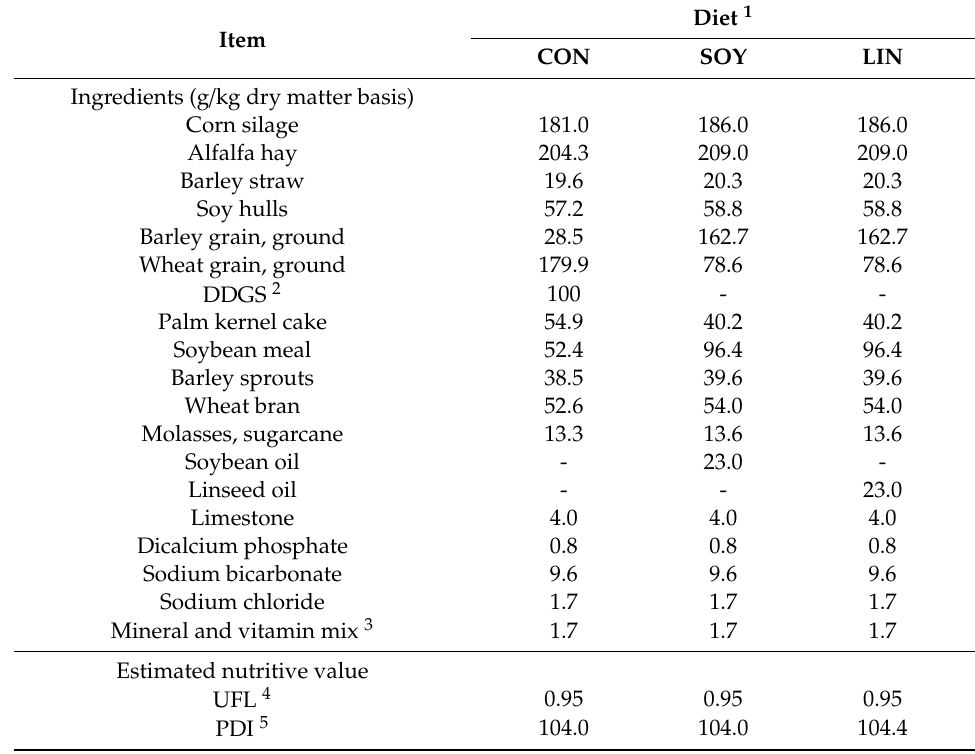
Table 1. Ingredients and estimated nutritive value of the experimental